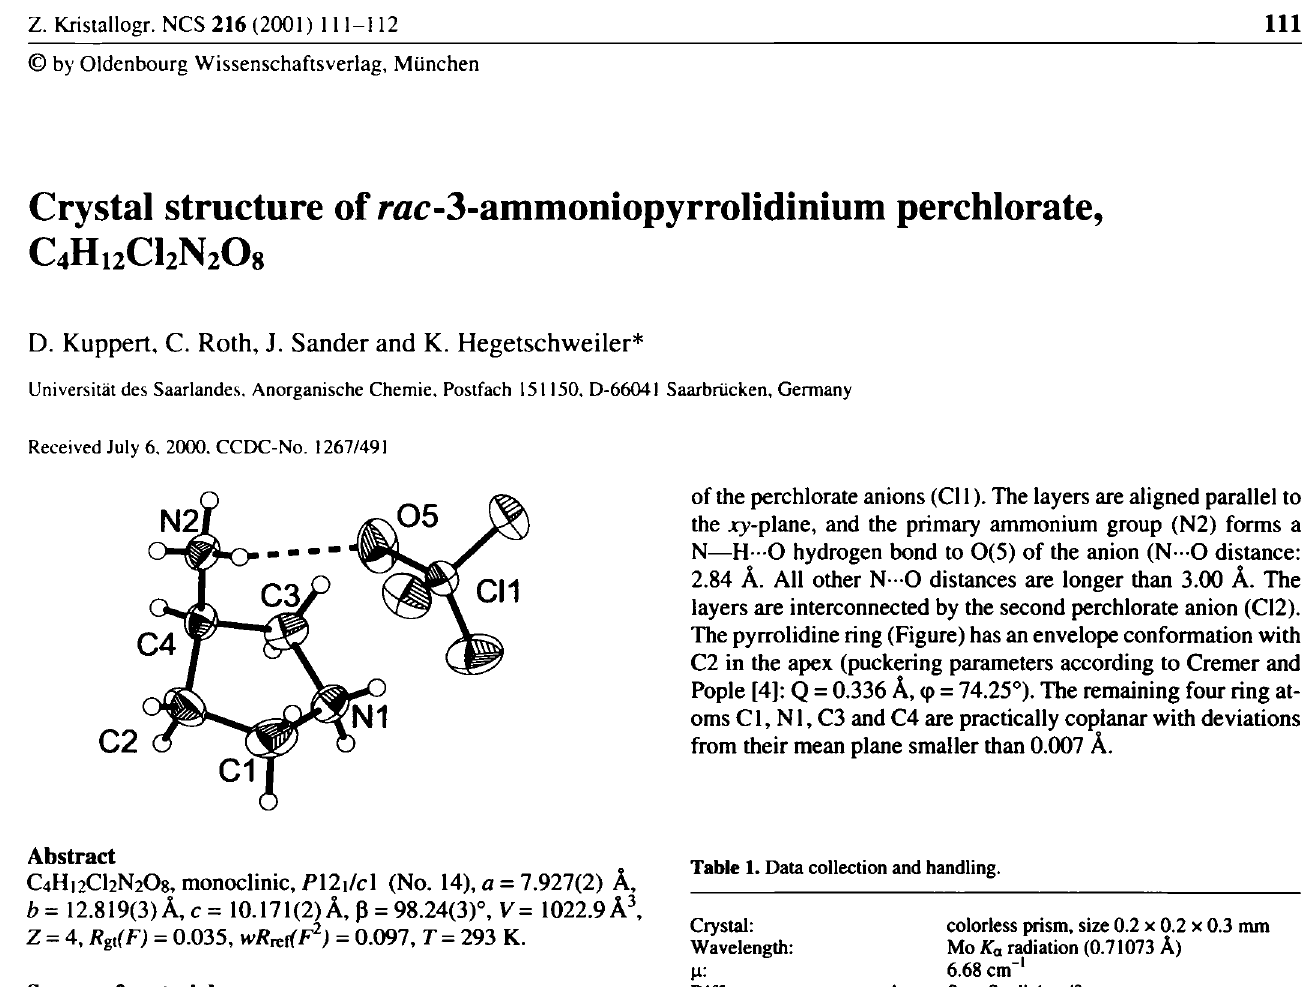
Table 2. Atomic coordinates and displacement parameters (in Ä 2